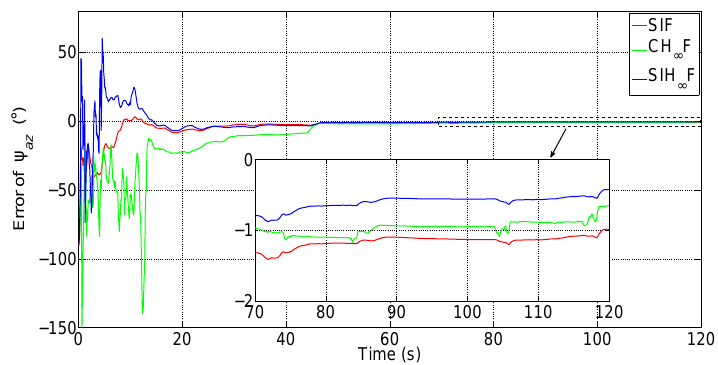
Figure 17. Error of ψ az (the subfigure is the magnification of the estimation result during 70 s–120